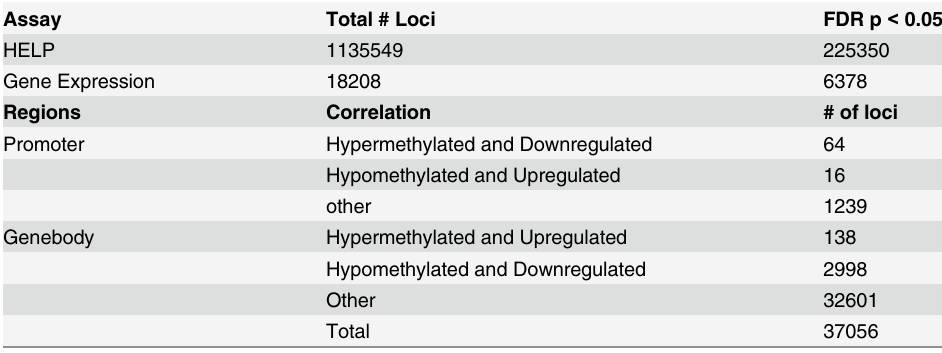
Table 3. Merge of Differential Methylation and Differential Expression (Adenocarcinomas